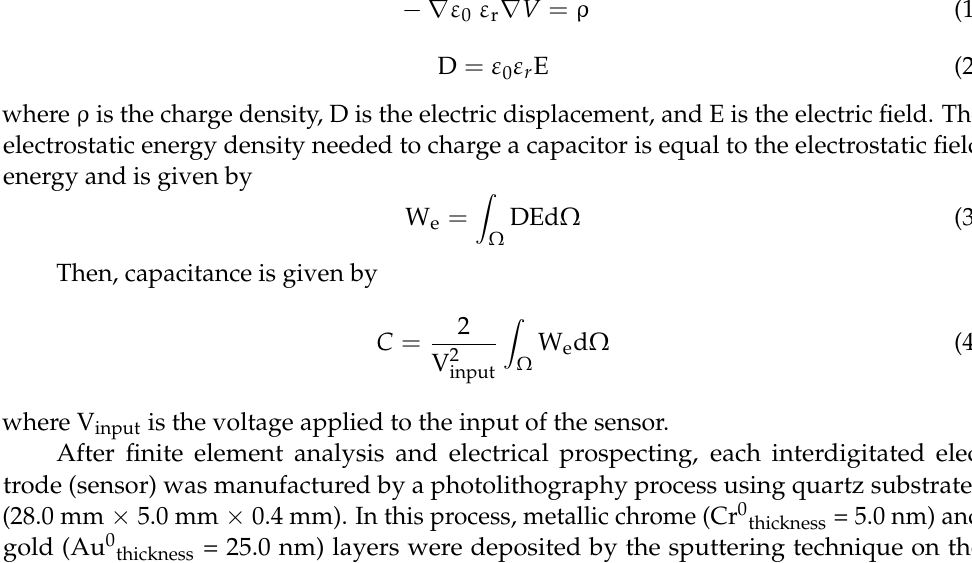
Figure 1. Two-dimensional (2D) schematic representation of the interdigitated electrodes. Dielectric studies were performed using the electrostatic interface available on the AC/DC module of the COMSOL Multiphysics platform. In this way, the electric field dis- tribution, electric field magnitude, and the capacitance for each electrode were predicted using a 3D-planar geometric model developed with 231,894 tetrahedral elements and ap- propriate boundary